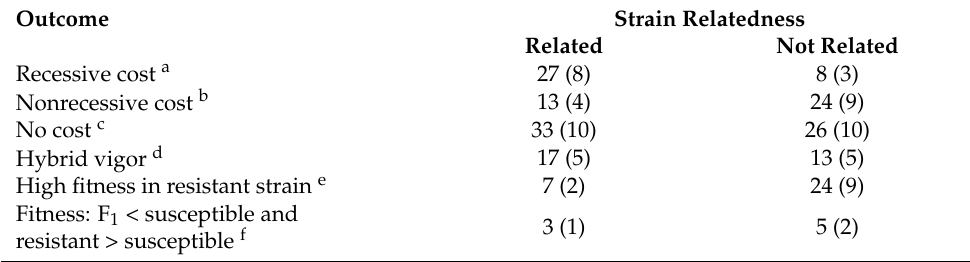
Table 2. Outcome of fitness comparisons between the resistant strain and F 1 progeny relative to the susceptible strain for cases involving related strains ( n = 30) or unrelated strains ( n = 38). The percent- age of cases (number in parentheses) for each outcome is shown. Fitness comparisons are based on the values of W R/S and W RS/S and do not necessarily reflect statistically significant differences. Outcome Strain Relatedness Related Not Related Recessive cost a 27 (8) 8 (3) Nonrecessive cost b 13